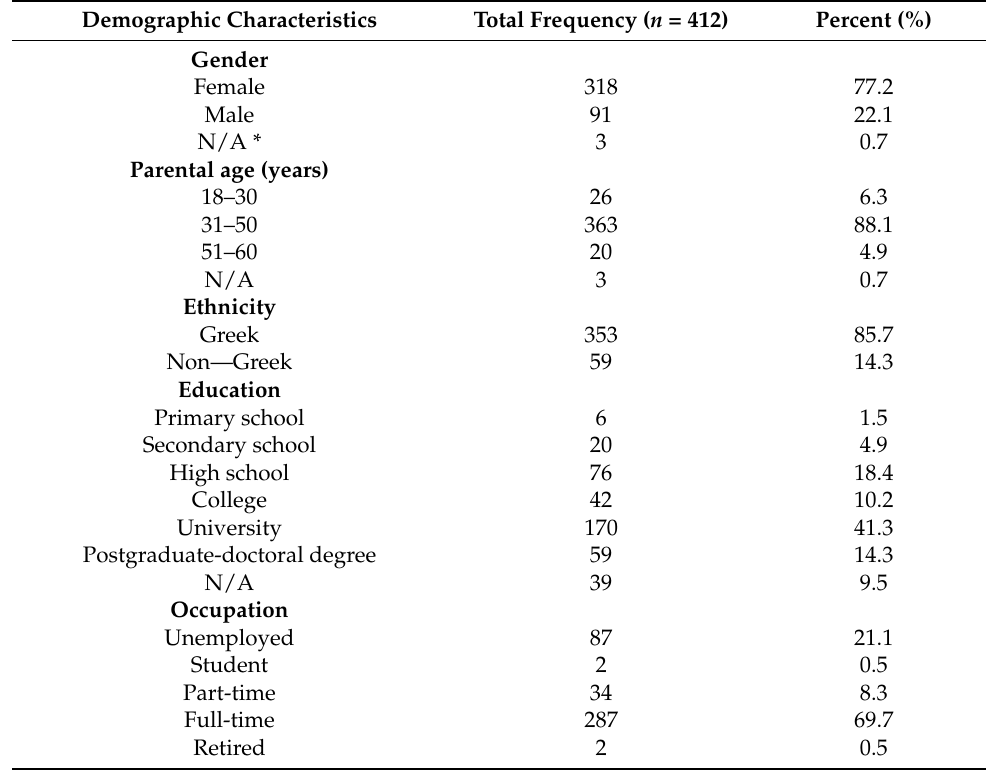
Table 1. Demographic characteristics of the study participants. Demographic